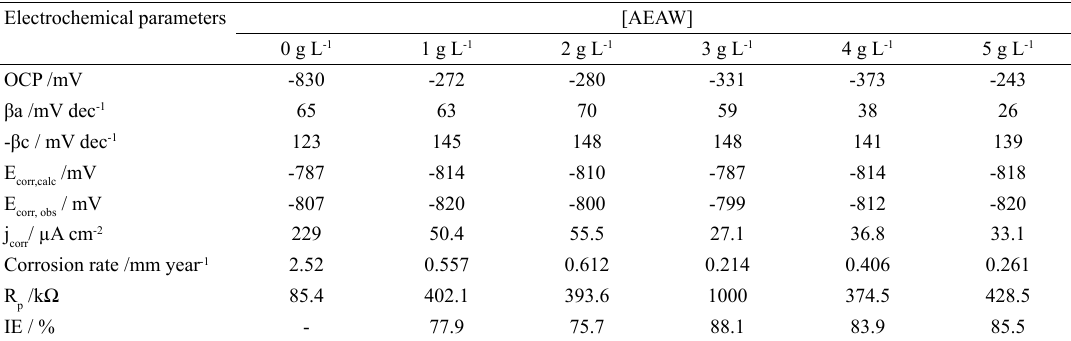
SO in presence and absence of AEAW. 2 4